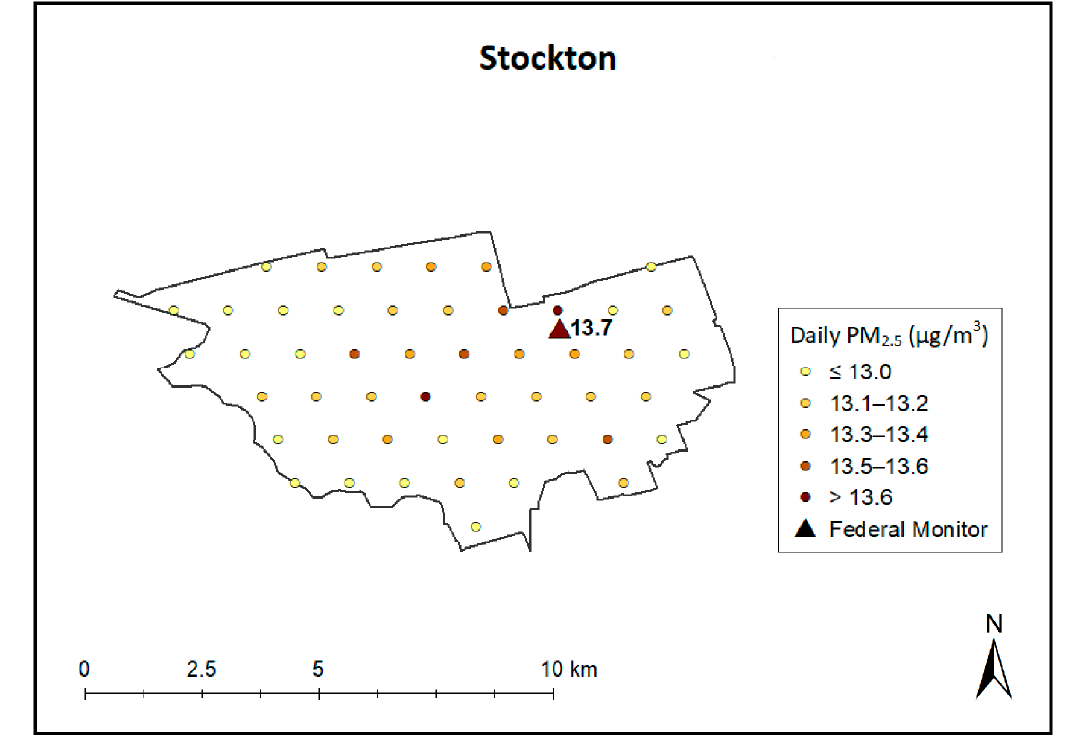
Figure 4 . Four-year daily PM 2.5 averages of 1 km 2 grids vs. nearest federal monitor for 13 California CAPP communities (2020). Grids are represented by circles approximating their extent. Note that each map has its own scale of concentrations intended to highlight local gradients. Table 2. PM 2.5 concentrations and coefficient of variation (CV) by region, season, and ZIP Code size for 590 California ZIP Codes from 92 cities. The coefficient of variation (CV) represents the relative difference in PM 2.5 concentrations among grids within a ZIP Code, reported as a percent between 0–100. A larger CV indicates greater variance within a ZIP Code; a smaller CV indicates smaller variance within a ZIP Code. Variances within ZIP Codes were relatively small across all regions and seasons, increasing with larger ZIP